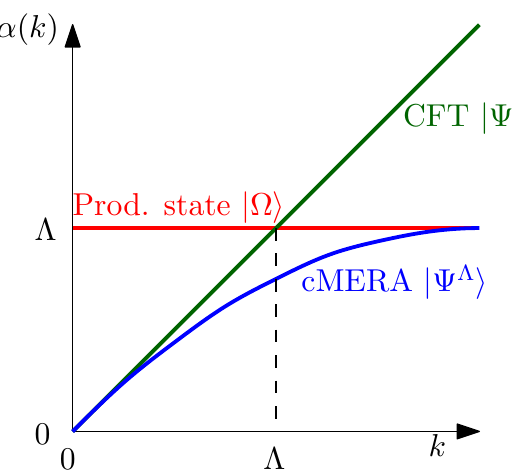
Figure 3 . Qualitative plot of the characteristic function (cid:11) ( k ) for the three states in the cMERA